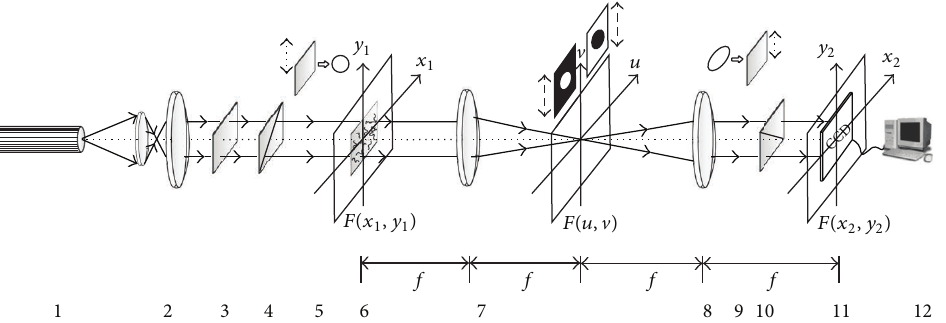
Figure 1: Optical scheme of Fourier polarimeter: 1—He-Ne laser, 2—a collimator, 3—a stationary quarter-wave plate, 5, 9—mechanically movable quarter-wave plates, 4, 10—a polarizer and analyzer, respectively, 6—object of study 7, 8—polarization microobjectives, 11—CCD camera, 12—a personal computer. 𝐹(𝑥 1 , 𝑦 1 ) —object plane, 𝐹(𝑥 2 , 𝑦 2 ) —image plane, and 𝐹(𝑢, V ) —Fourier plane with the